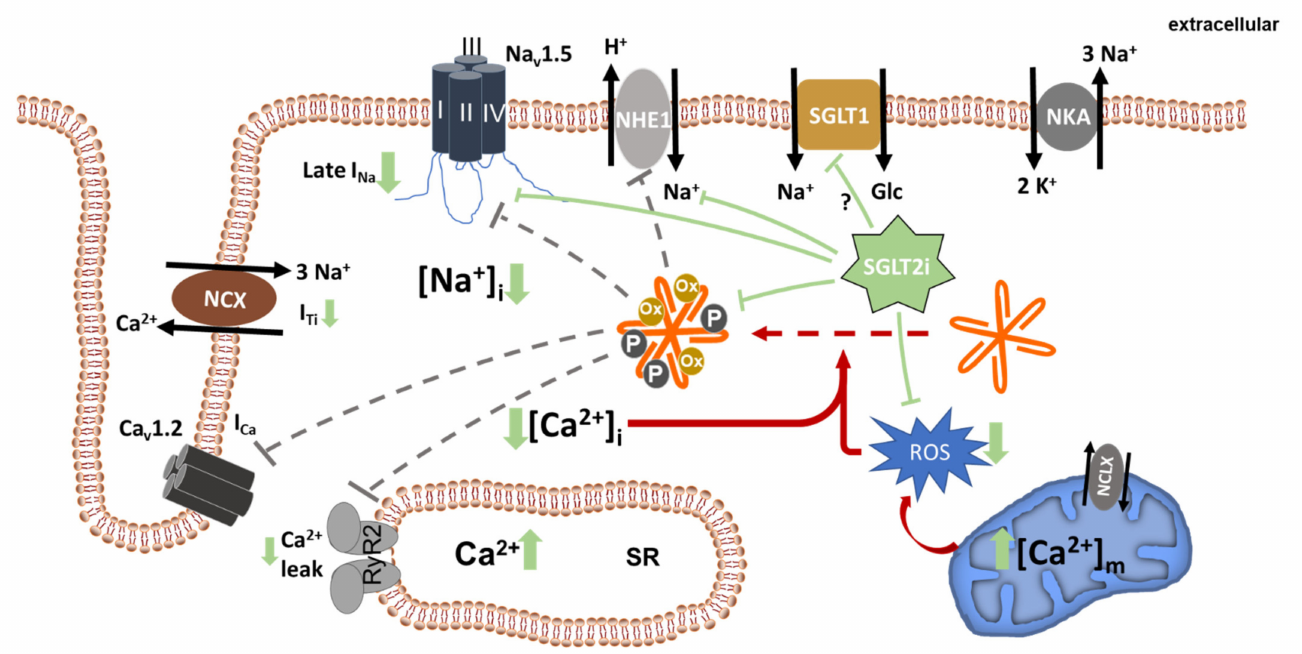
Figure 2. Beneficial effects of SGLT2i on cellular ion homeostasis. SGLT2i directly or indirectly inhibit NHE1, late I Na , and CaMKII, leading to a reduction in cellular Na + and Ca 2+ overload. As a consequence of reduced [Na + ] and possibly also because of direct mitochondrial effects of SGLT2i, mitochondrial ROS generation is decreased. Dashed grey lines indicate potentially reduced interaction of CaMKII with its known targets. Solid green lines indicate inhibition mediated by SGLT2i. NKA, Na + /K + ATPase; RyR2, ryanodine receptor 2; SR, sarcoplasmic reticulum; NCX, Na + /Ca 2+ exchanger; NCLX, mitochondrial Na + /Ca 2+ exchanger; ROS, reactive oxygen